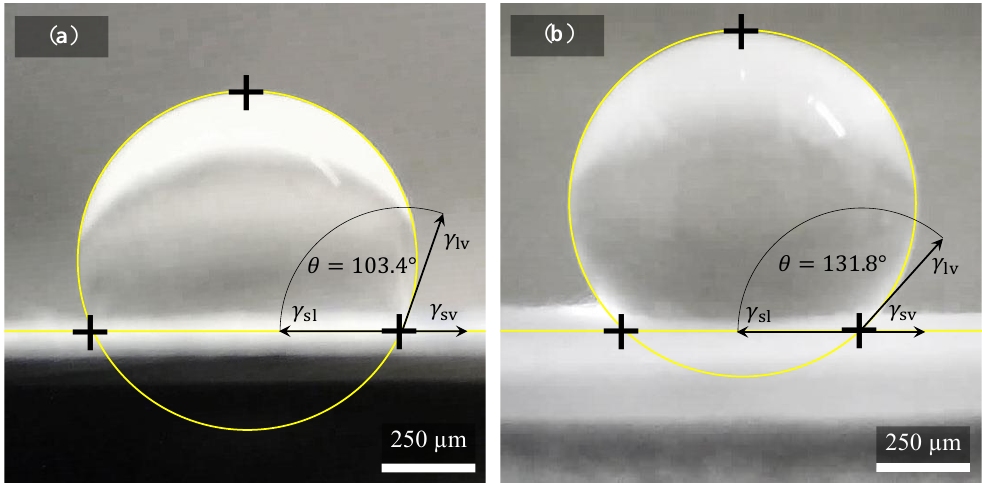
Figure 9. Hydrophobicity and hydrophilicity measurement. Each image shows 3µL droplet on the specimens surface. Images show the droplet on surface of ( a ) disordered and ( b ) ordered fibers spun at 300rpm and 2000rpm, respectively. The different wettability of both structures is